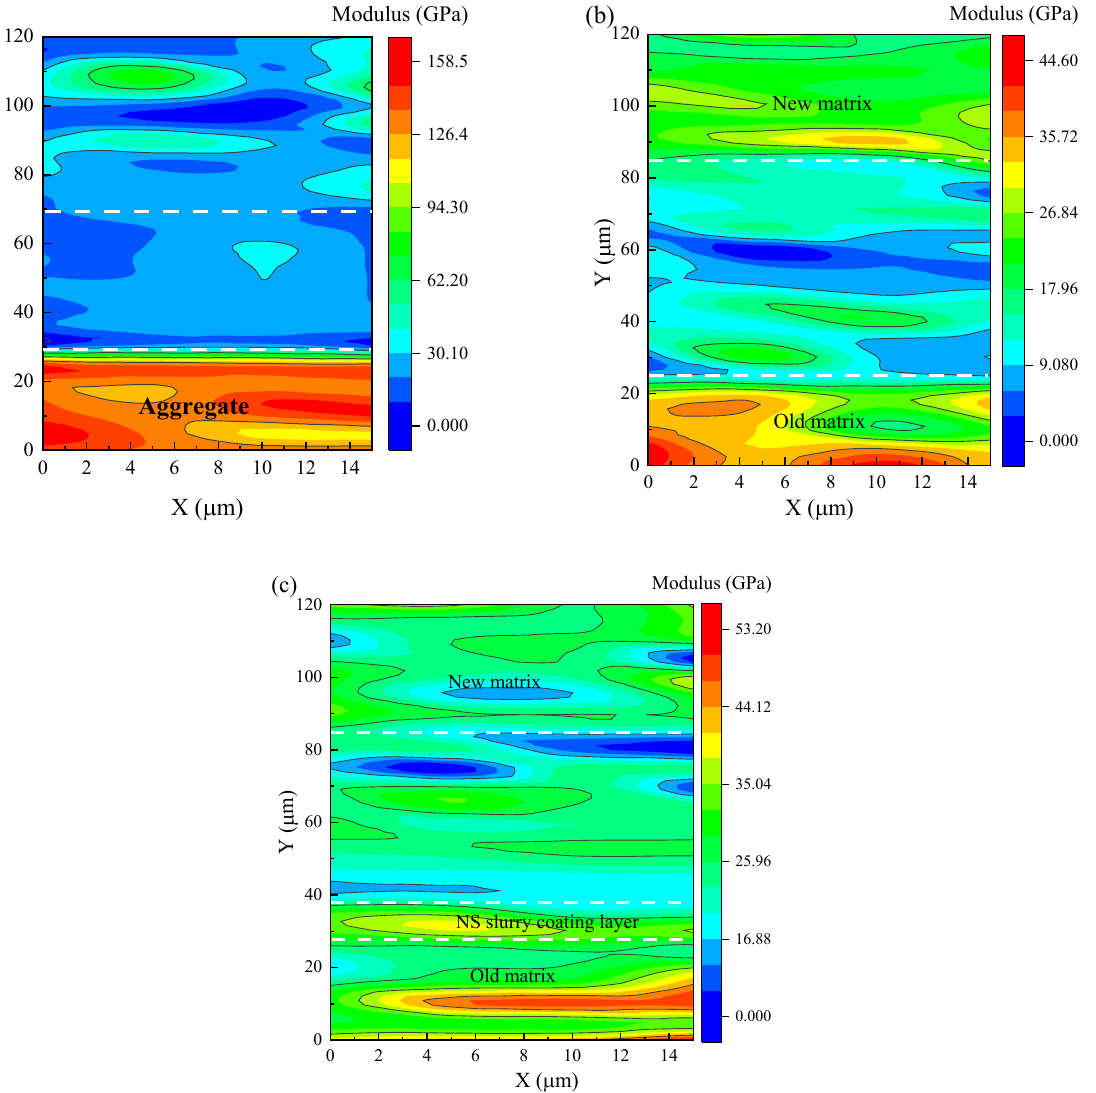
Figure 8. Contour maps for the ITZs ( a ) NAC-100, ( b ) RAC-100, and ( c ) MRAC-100.